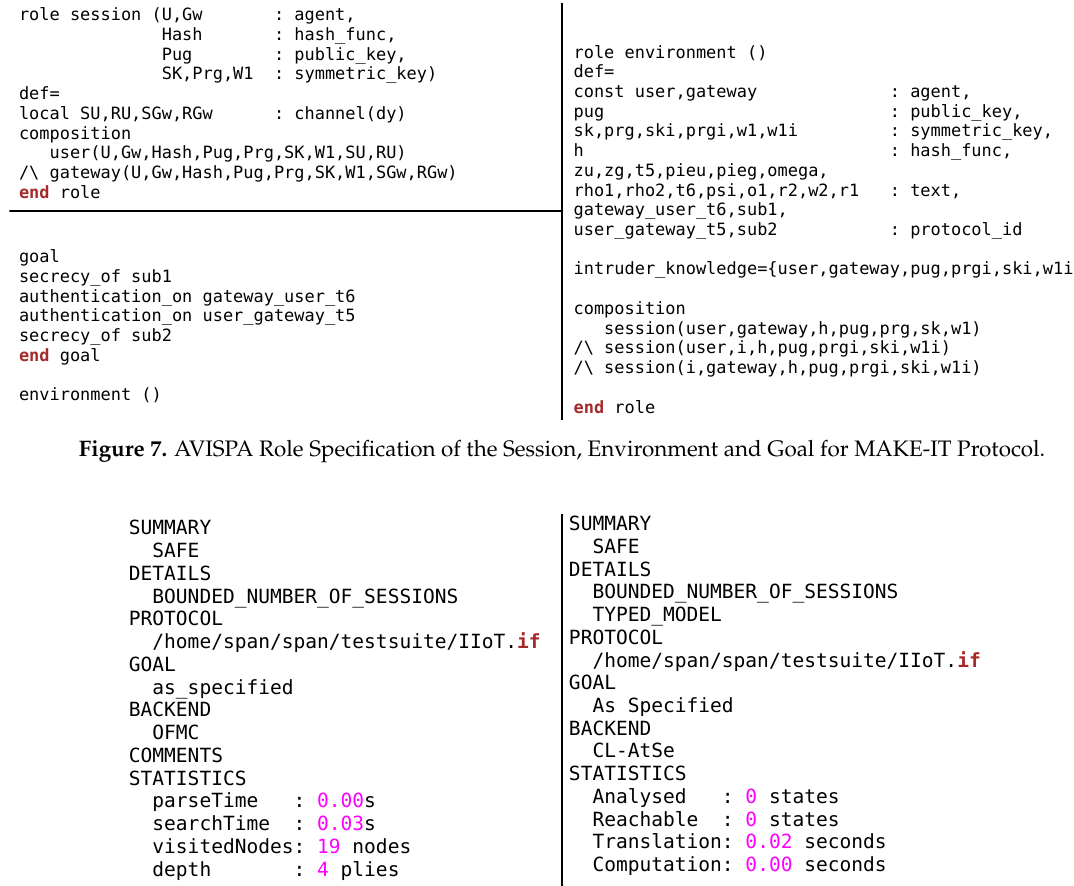
Figure 8. AVISPA results by using on-the-fly model-checker (OFMC) and Constraint-Logic-based ATtack SEarcher (CL-AtSe) backend for our proposed MAKE-IT